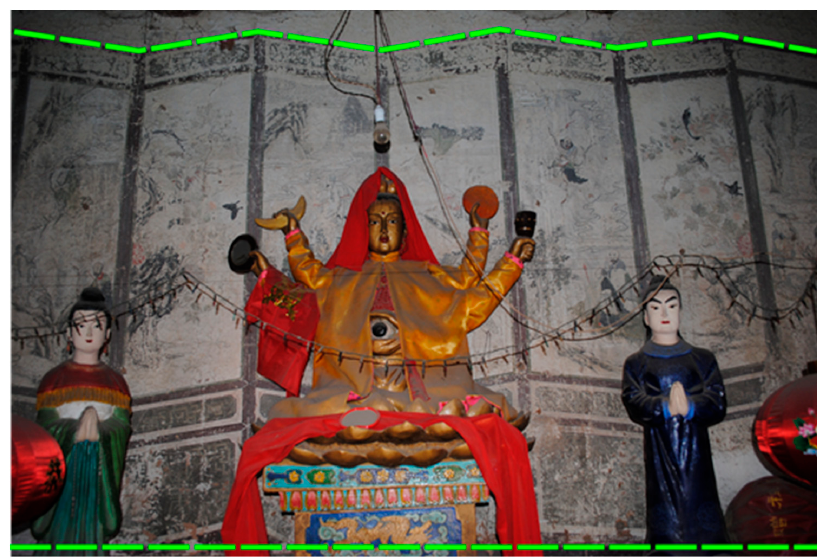
Figure 3. Hanging screen depicting ladys in the Xiangu Temple in Shangdongfeng Village (No. 51 in Figure 1).